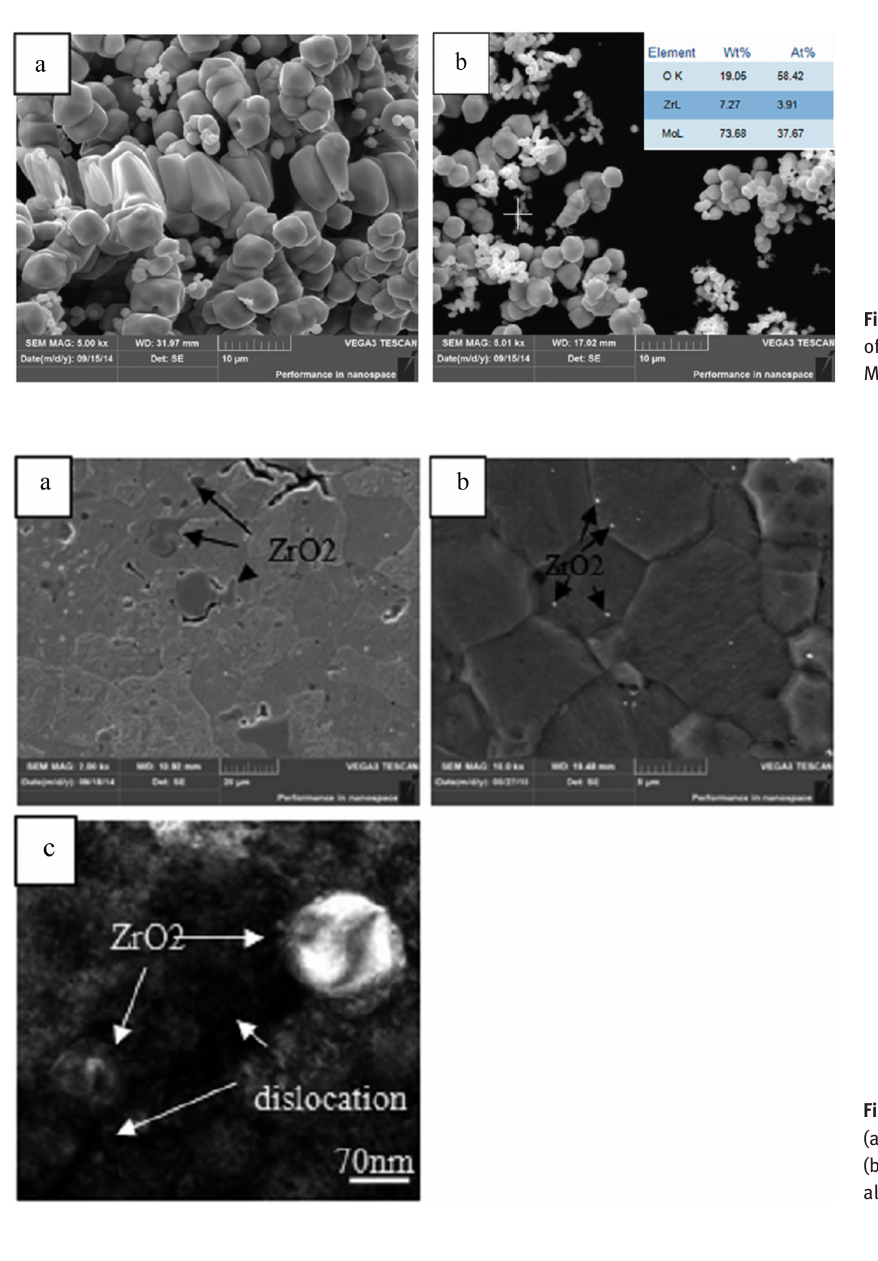
Figure 2: SEM photo of ZrO 2 /Mo alloy: (a) 4* × 2.00 kx (Reference sample); (b) 5 × 10.00 kx (New method); (c) TEM of